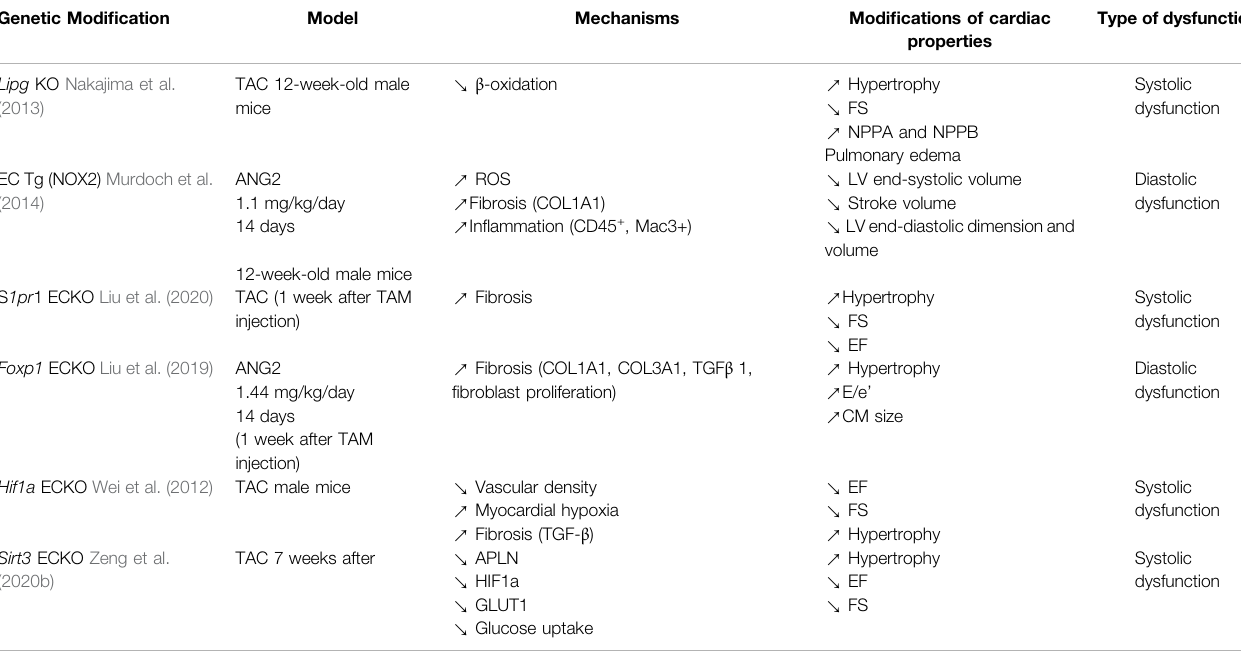
TABLE 2 | Genetic modi fi cations of EC exacerbating cardiac dysfunction. Genetic Modi fi